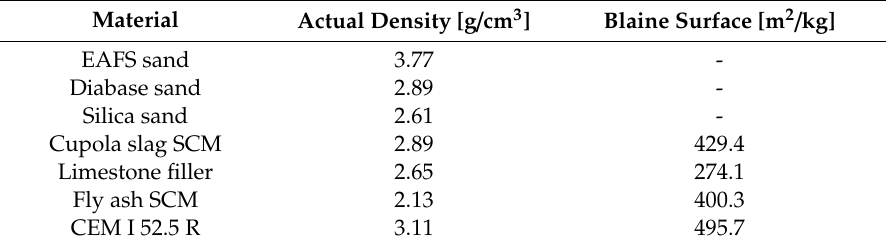
Table 2. Main properties of the sands, supplementary cementitious materials (SCMs) and cement used in the SCC.